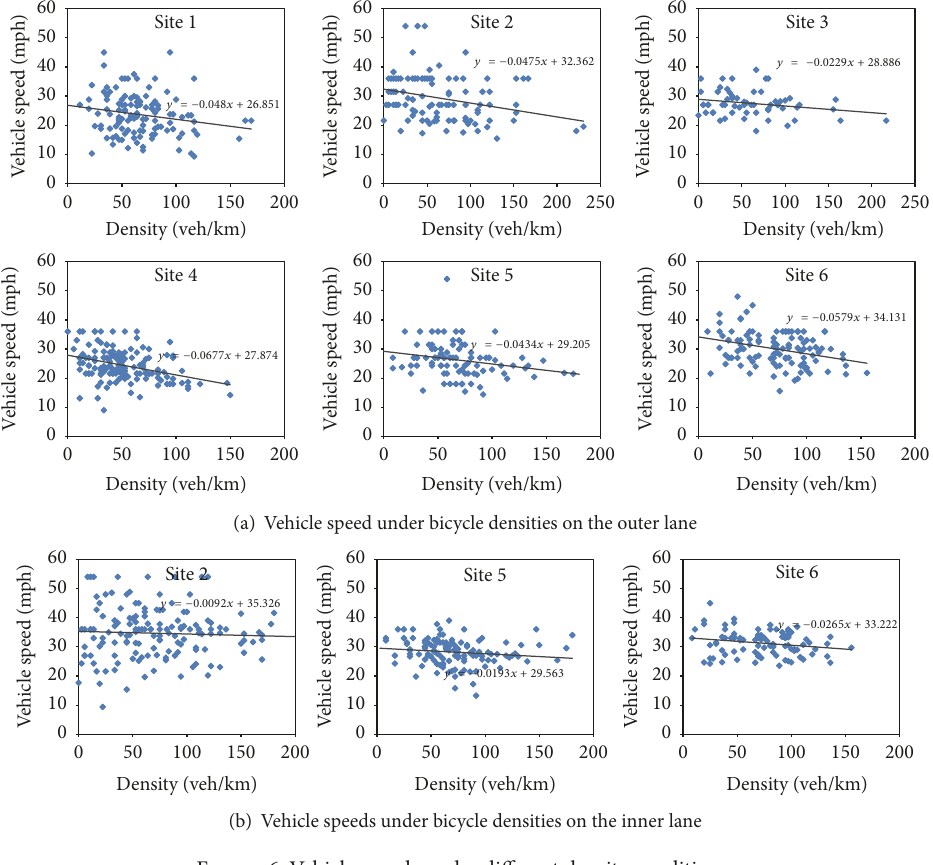
Figure 6: Vehicle speeds under different density conditions.